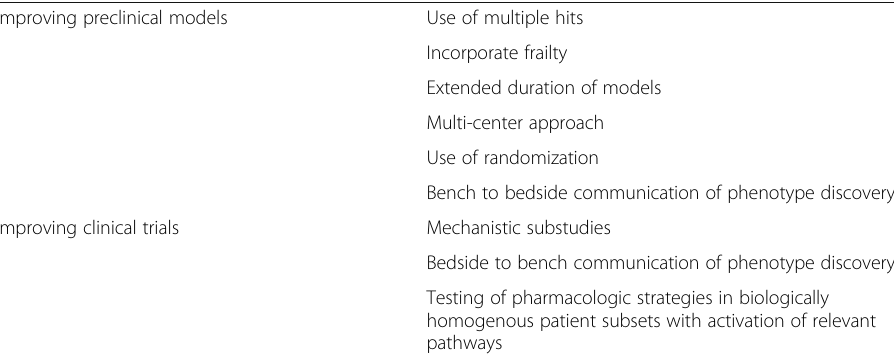
Table 1 Suggestions to improve translational study design in critical care Improving preclinical